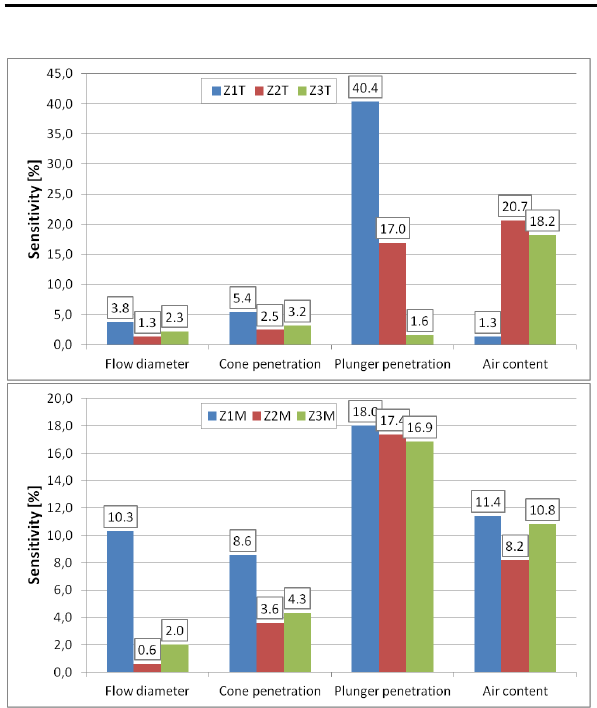
Figure 4: The sensitivity of the properties of plasters (top) and mor- tars (bottom) to ± 10% mistake of admixture/lime